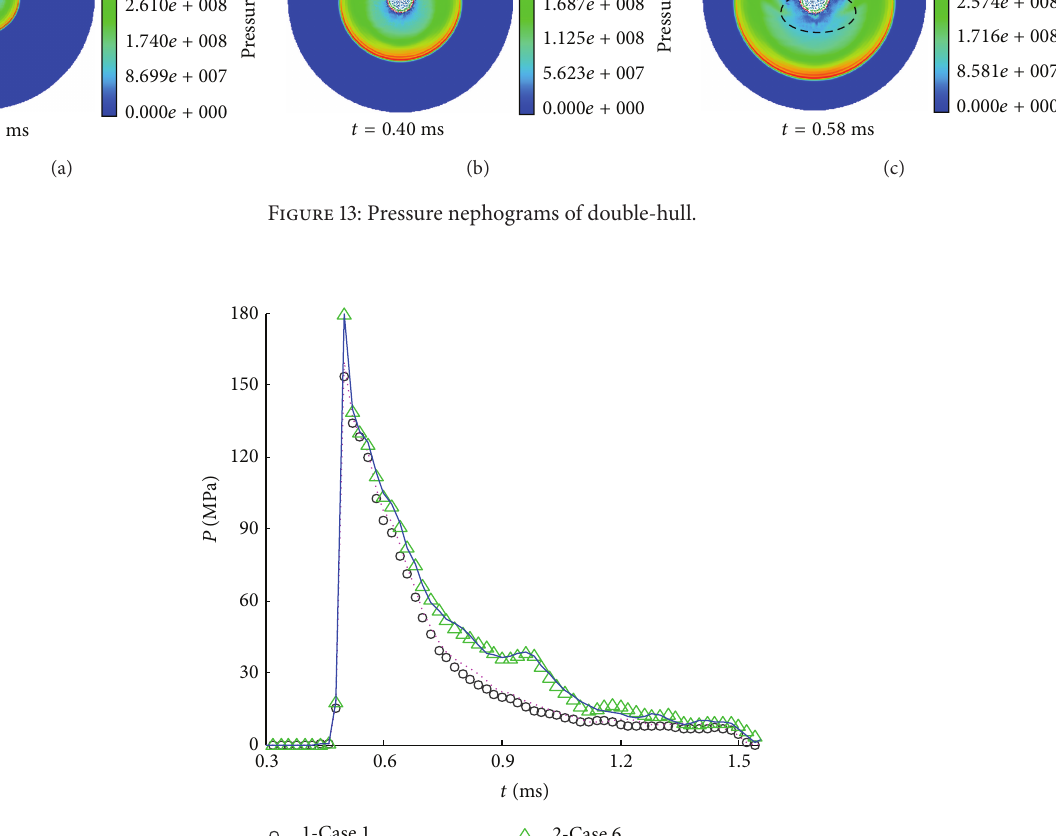
Figure 12: Models of double-hull.